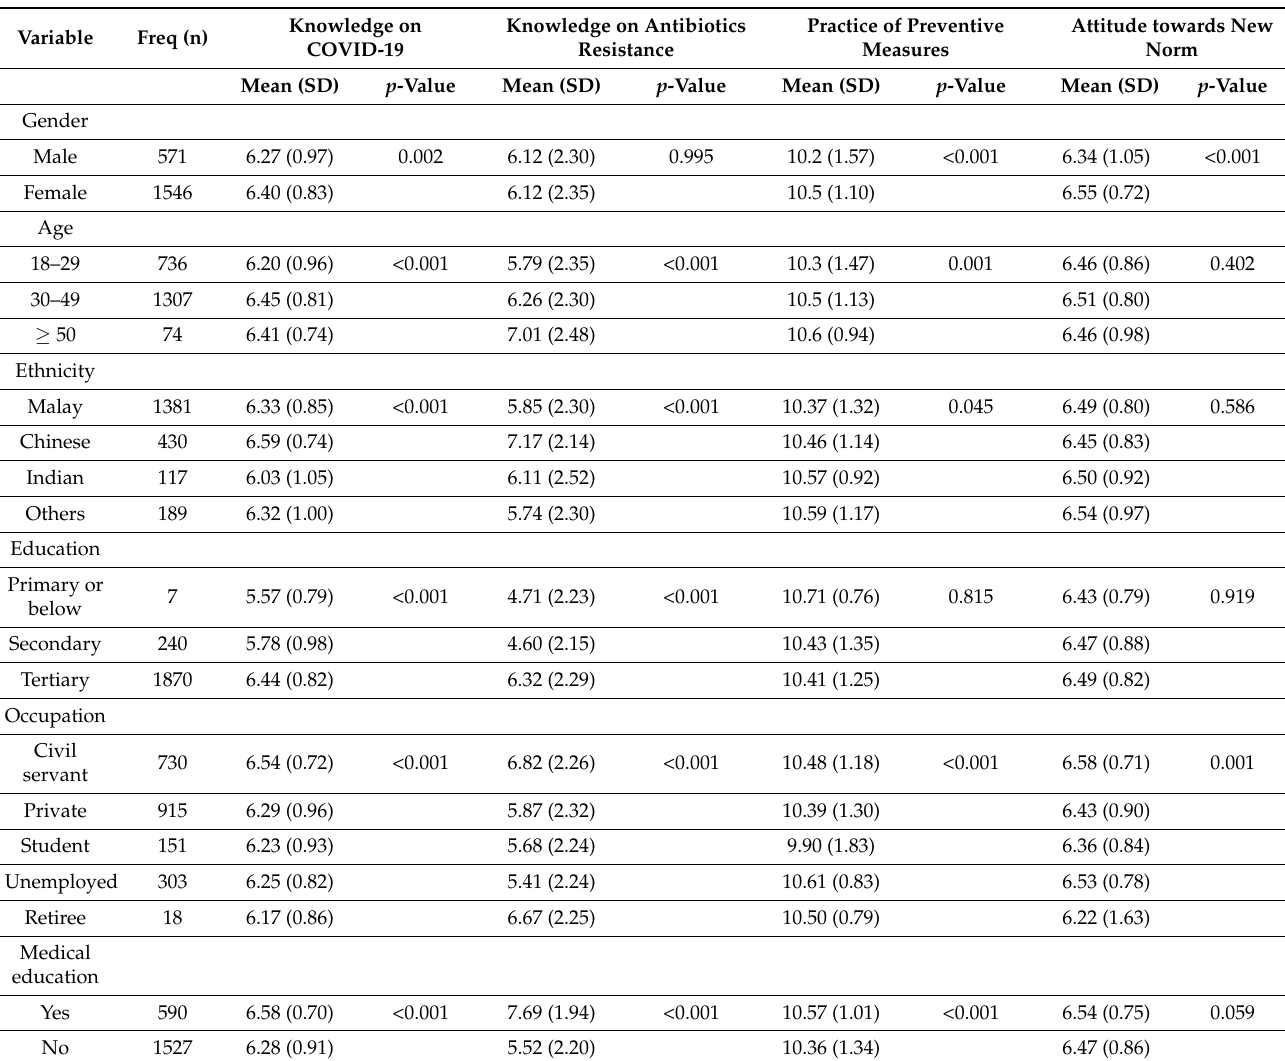
Table A1. Comparison of demographic characteristics with knowledge, practice and attitudes score ( n =